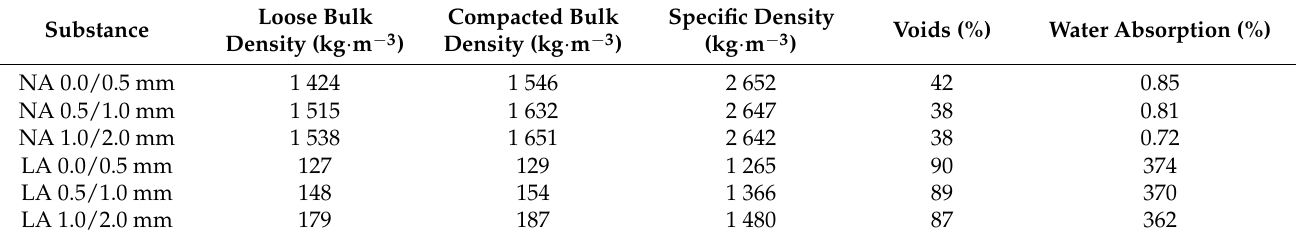
Table 3. Physical properties of both aggregate types.